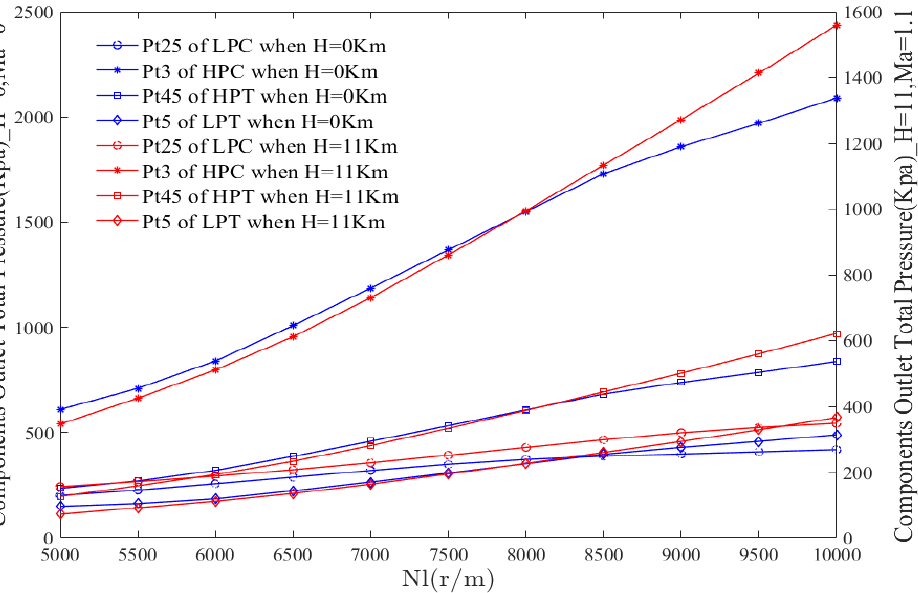
Figure 3. Total pressures of components. Processes 2019 , 7 , x FOR PEER REVIEW